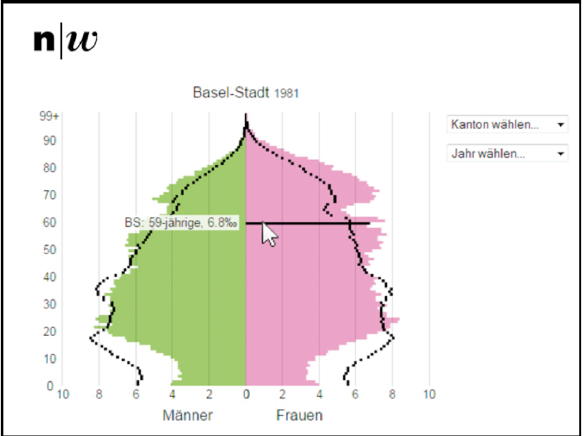
Figure 6: Prototype for “expert